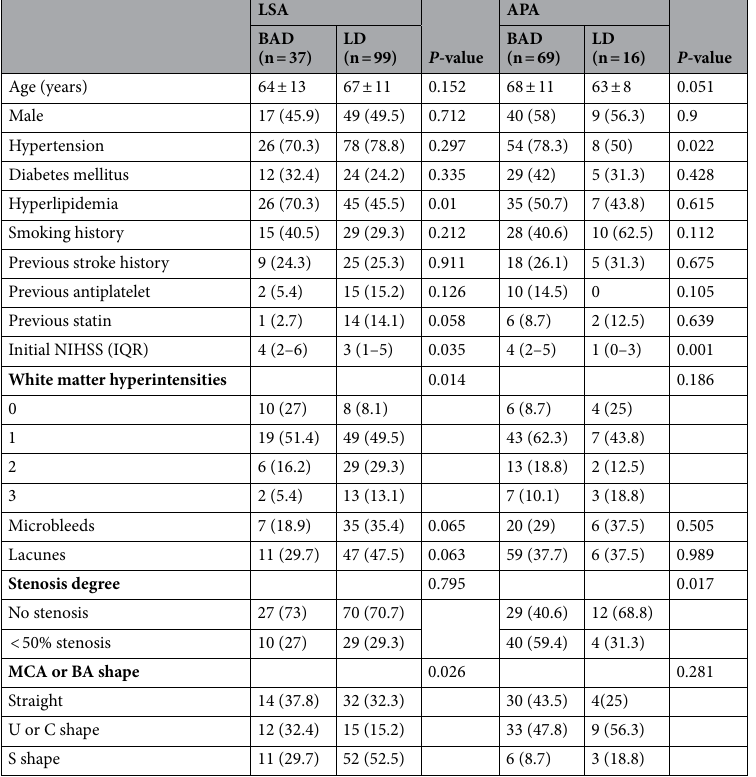
Table 2. Characteristics in the BAD and LD groups in the two different territories. Results presented as number and percent (%) or mean ± SD or IQR. LSA: Lenticulostriate arteries, APA: Anterior pontine arteries, MCA: middle cerebral artery, BA: basilar artery, BAD: branch atheromatous disease, LD: lipohyalinotic degeneration; NIHSS: National Institutes of Health Stroke